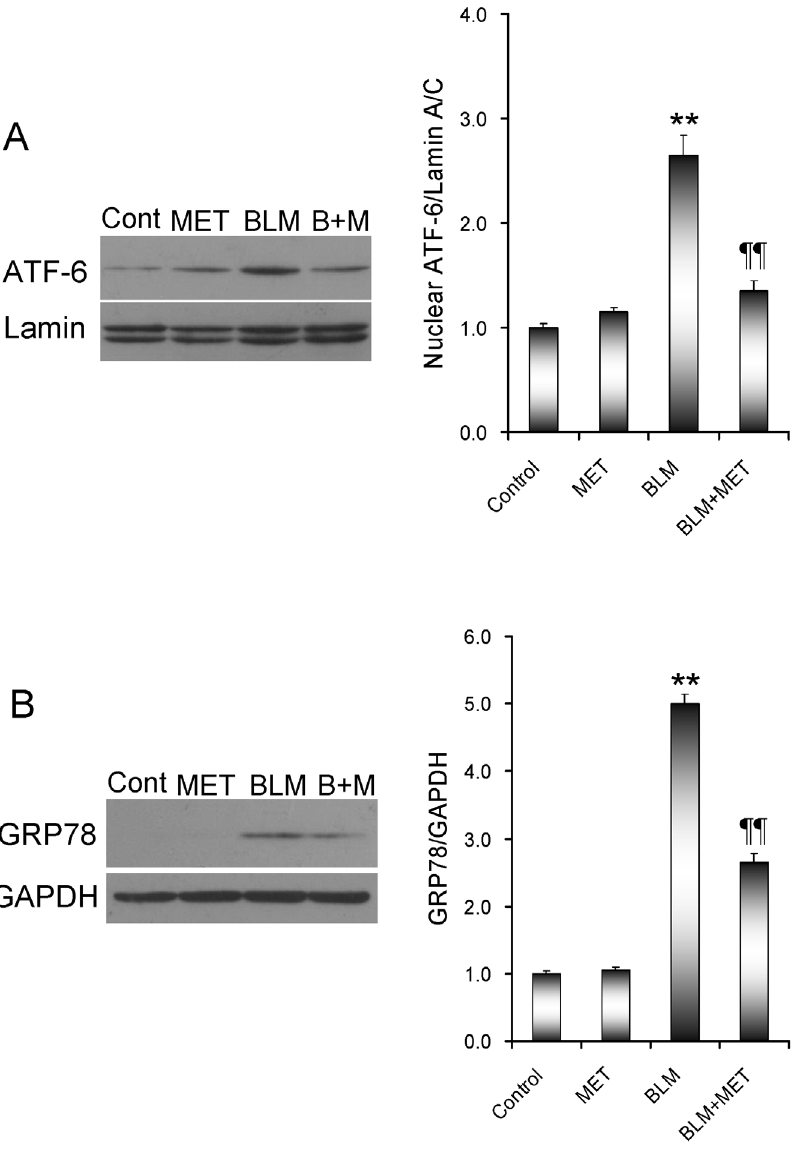
Figure 4. The effects of melatonin on BLM-induced activation of ATF6 path way in the lungs. All mice except controls were intratrac- + melatonin group, mice were i.p. injected with melatonin (5 mg/kg) daily. Lungs were collected at 21 days were replicated for four times. The data were expressed as means 6 SEM (n=4). ** P , 0.01 as compared with control group. `` P , 0.01 as compared with BLM